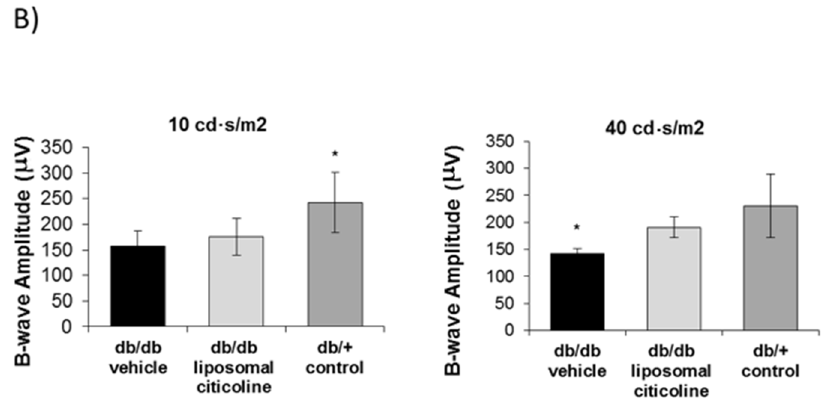
Figure 5. Effect of citicoline on electroretinography (ERG)abnormalities. ( A ) ERG traces in response to low (10 cd · s/m 2 ) and medium (40 cd · s/m 2 ) stimulus intensities in a representative mouse of each investigational group. Red line: db/db-vehicle. Black line: db/db-citicoline. Green line: db/+ (non-diabetic control); ( B ) quantitative analyses of amplitude of b-wave in db/db treated with vehicle, db/db treated with citicoline, and non-diabetic mice. Results are mean ± SD. * p < 0.05 in comparison with the other